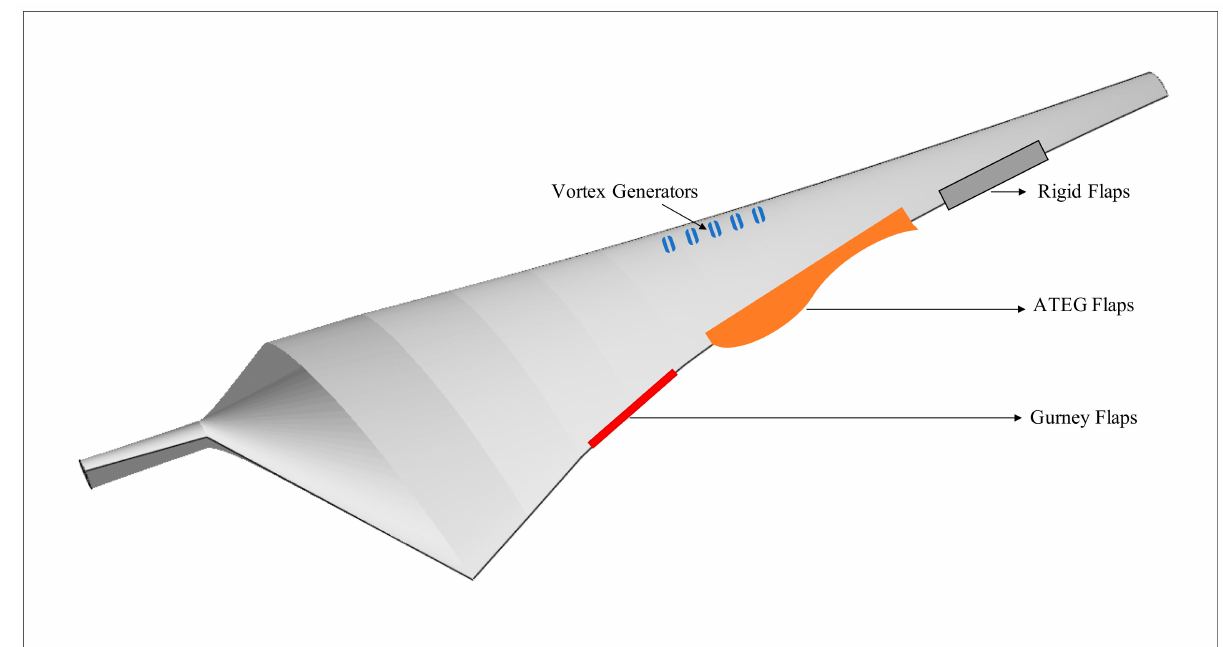
Figure 4. Wind turbine blade illustrating various flow control